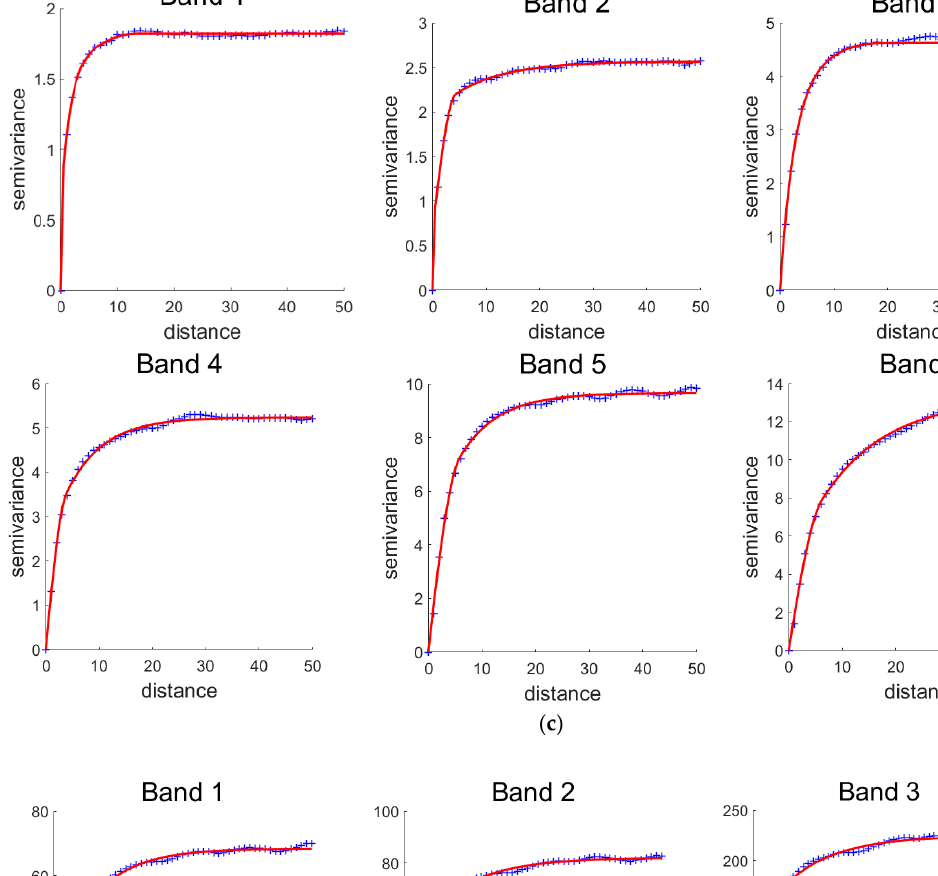
∼ Z (cid:48) ). ( c ) MNF-transformed image bands ( Z (cid:48) 6 1 ∼ Z 6 1